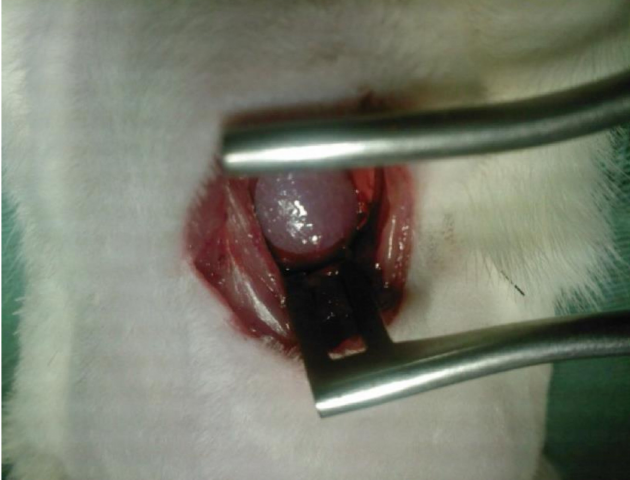
Figure 2. Placement of the cellulose patch on the left